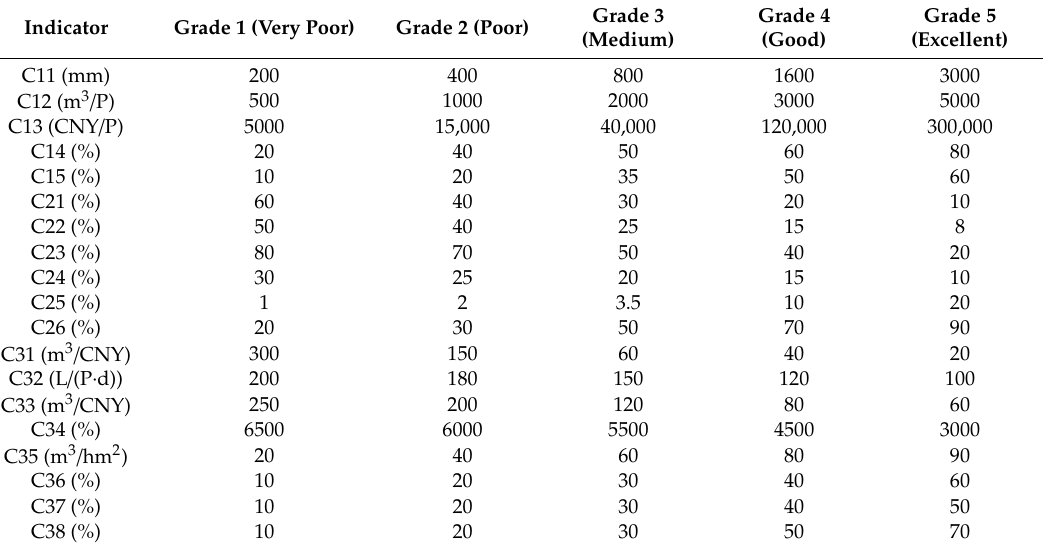
Table 7. The grading standards for the indicators in the index layer for the Beijing SWRS.